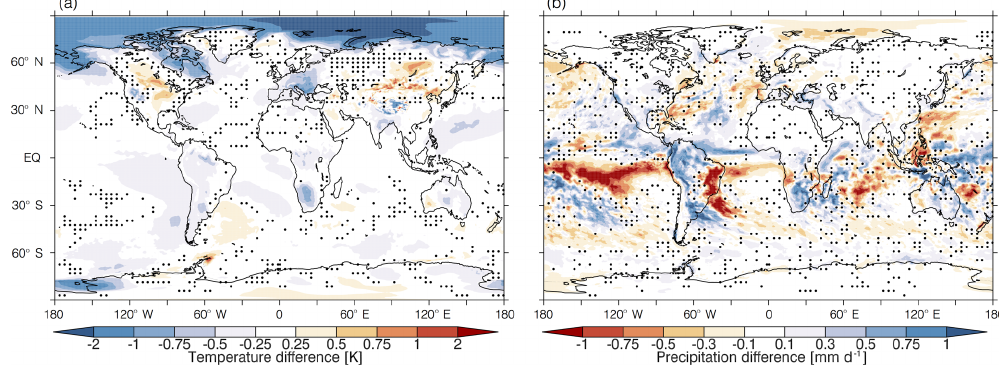
Figure 4. Ensemble mean, (1998–2012) vs. (1979–1993), difference in (a) near-surface temperature, and (b) precipitation. Dots indicate where the response is not significant at the 10% level, as calculated using a two-tailed Student’s t test. Figure 6a and b show the agreement of individual ensemble members on the sign of the temperature and precipitation anomalies